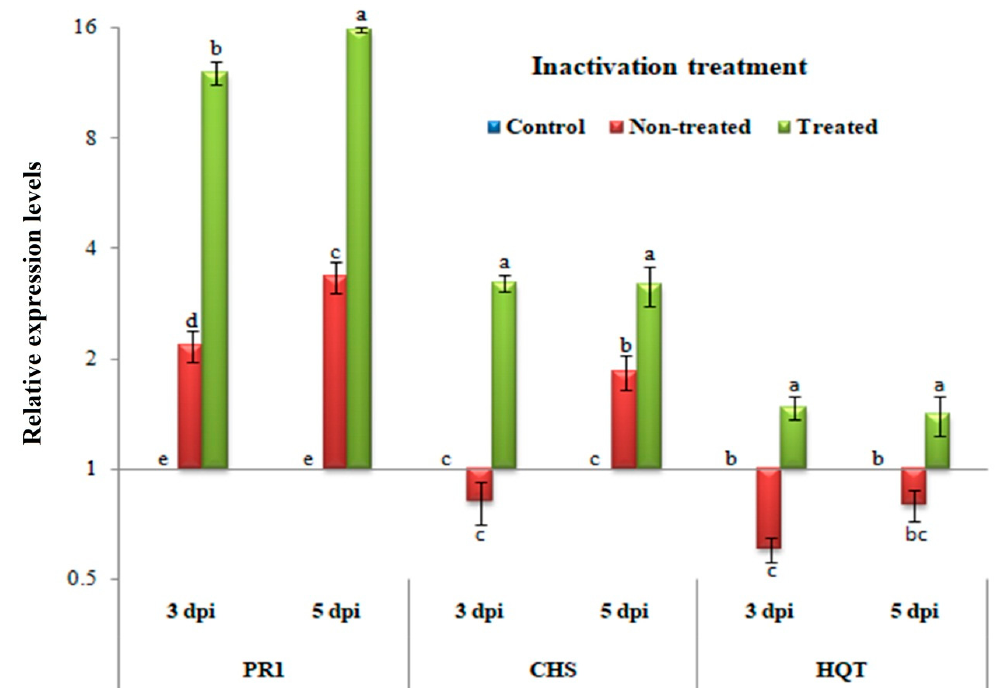
Figure 5. A histogram showing the relative expression levels of the PR-1, CHS, and HQT genes at 3 and 5 dpi of H. tuberculatum WPE treatments (200 μ g/mL) in the inactivity assay. Control = mock-treated plants; non-treated = plants inoculated with TMV only without any treatment; treated = plants treated with H. tuberculatum WPE, 24 h before inoculation of TMV for the protective assay and 24 h after inoculation of TMV for the inactivity assay. Columns represent a mean value from three biological replicates and bars indicate SD. Significant differences between samples were determined by one-way ANOVA using CoStat software. Means were separated by the LSD test at p ≤ 0.05 and indicated by lowercase letters. Columns with the same letter do not differ significantly.